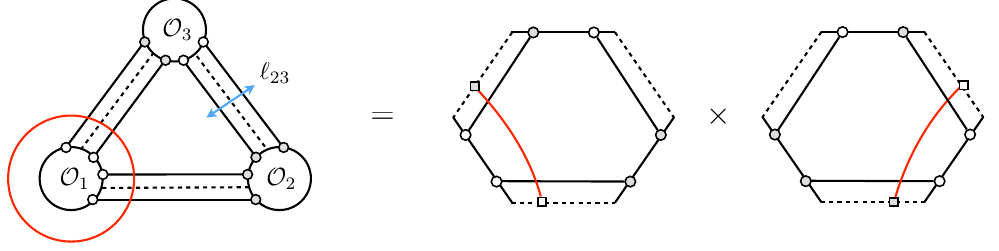
Figure 1 . Wheeled Feynman diagram contributing to a (cid:12)shnet structure constant. White and grey dots represent the (cid:12)elds (cid:30) 1 and (cid:30) y in the operators. Black and red lines represent propagators for 1 (cid:30) 1 and (cid:30) 2 , respectively. The bridge length ‘ ij counts the number of black propagators along each edge. Cutting along the three edges, as shown here in dashed lines, splits the Feynman diagram into two hexagons and cuts open the